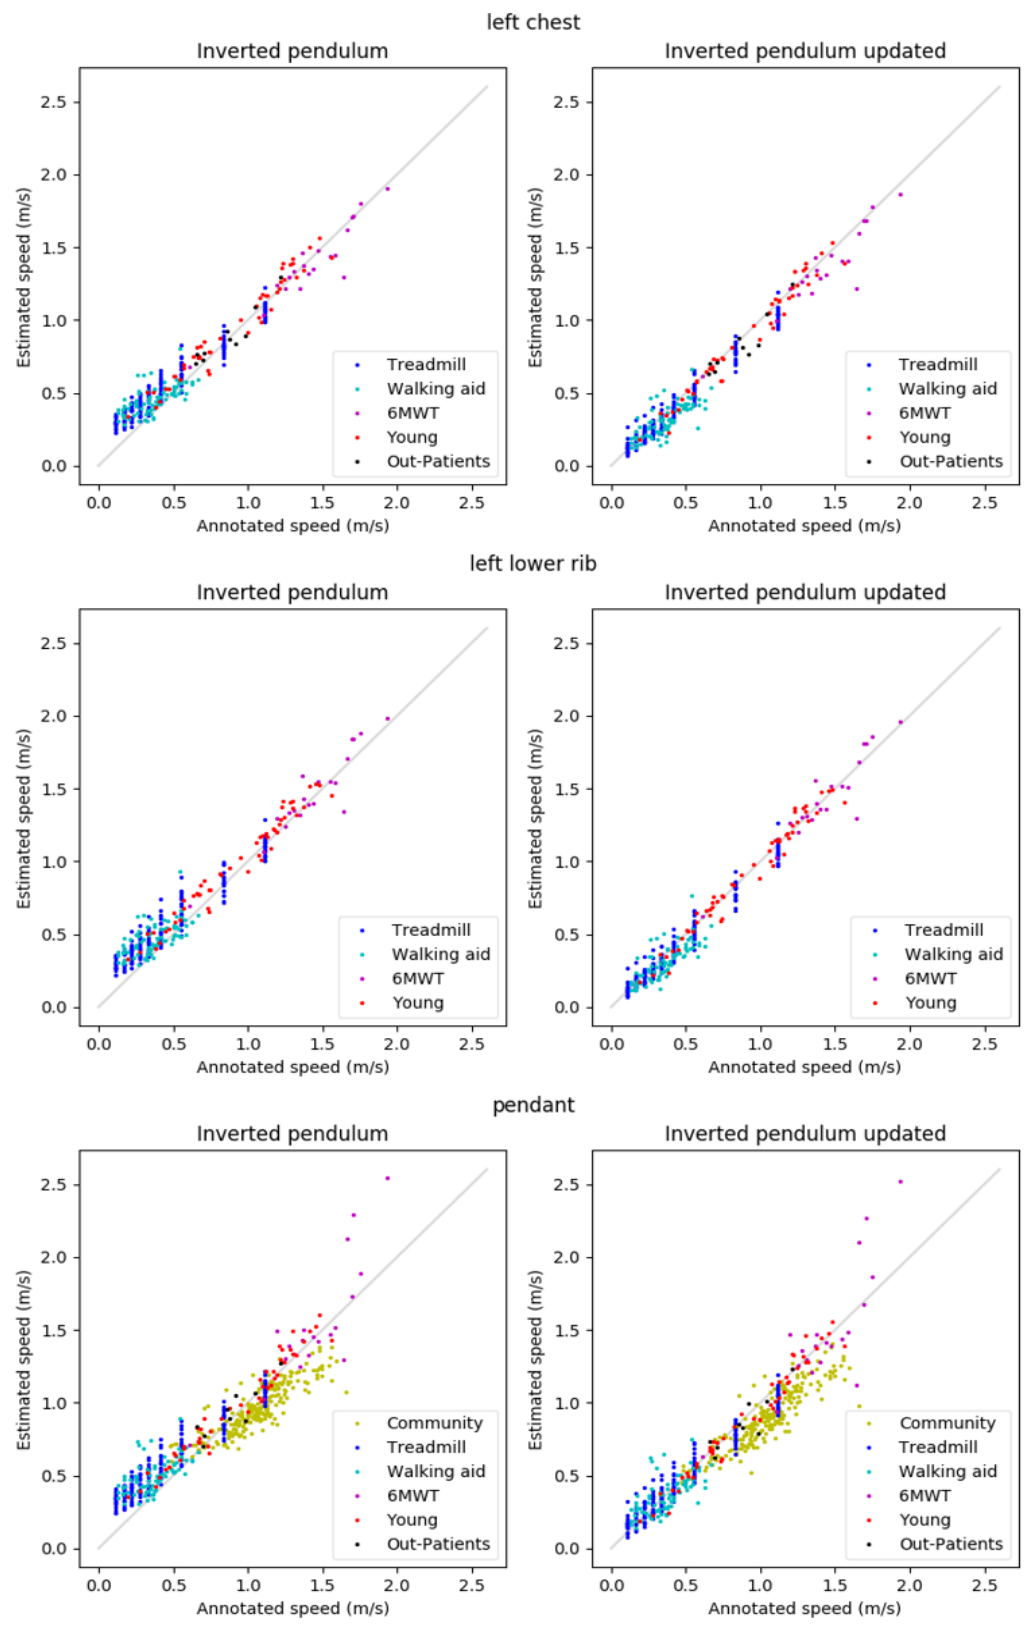
Figure 4. Results for the left chest ( top ), left lower rib ( middle ), and pendant ( bottom )